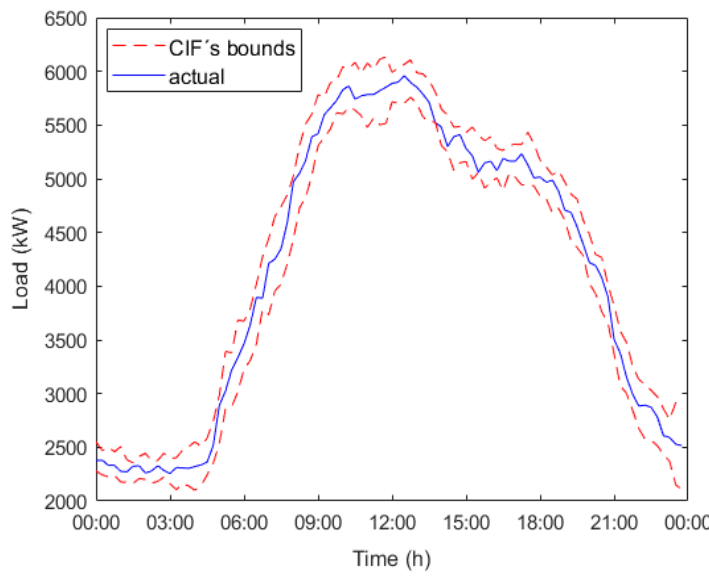
Figure 4. Predicted intervals and actual energy demand evolution for 8 February 2018 scenario (𝛼 = 0.10 , 𝐹 = 1546) .